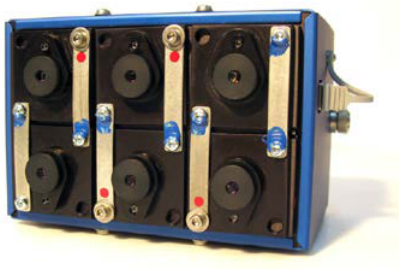
Figure 1. miniMCA multispectral camera